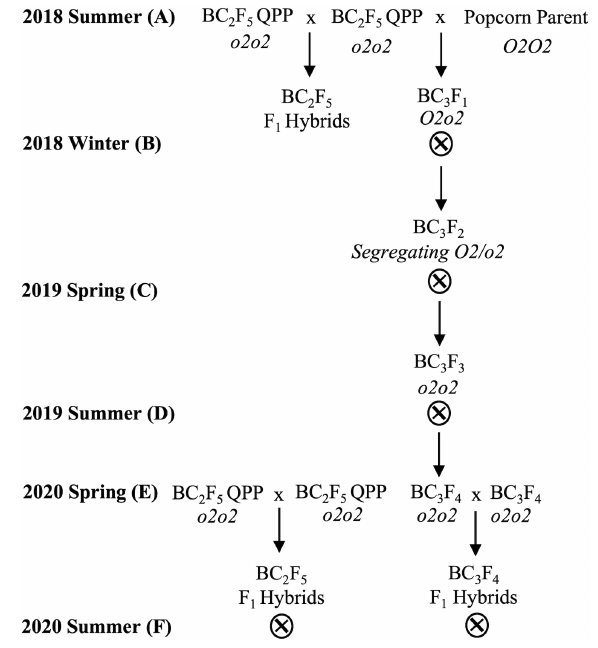
FIGURE 1 | Breeding scheme to produce BC 2 F 5 and BC 3 F 4 QPP F 1 hybrids. Overall breeding scheme from 2018 to 2020. (A) In the summer of 2018, BC 2 F 5 QPP inbreds were crossed in full diallel to produce F 1 hybrids. BC 2 F 5 inbreds were also selectively crossed to their respective original popcorn